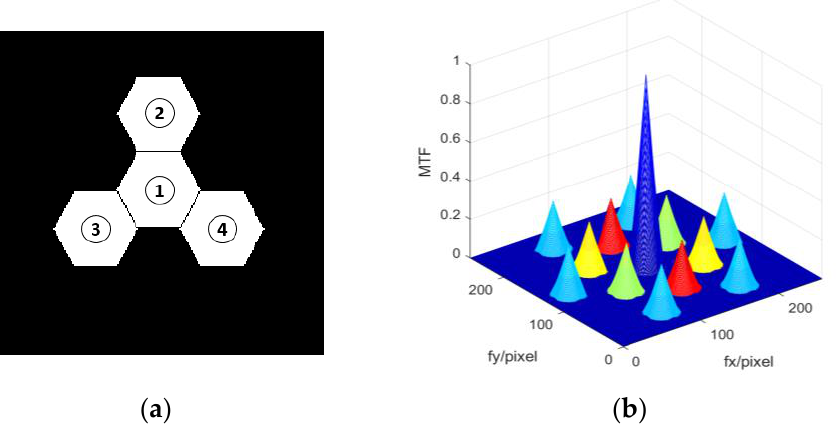
Figure 10. The 4 hexagonal segmented telescope showing ( a ) the position arrangement of the 4 sub-mirrors and ( b ) the corresponding system MTF colored without piston